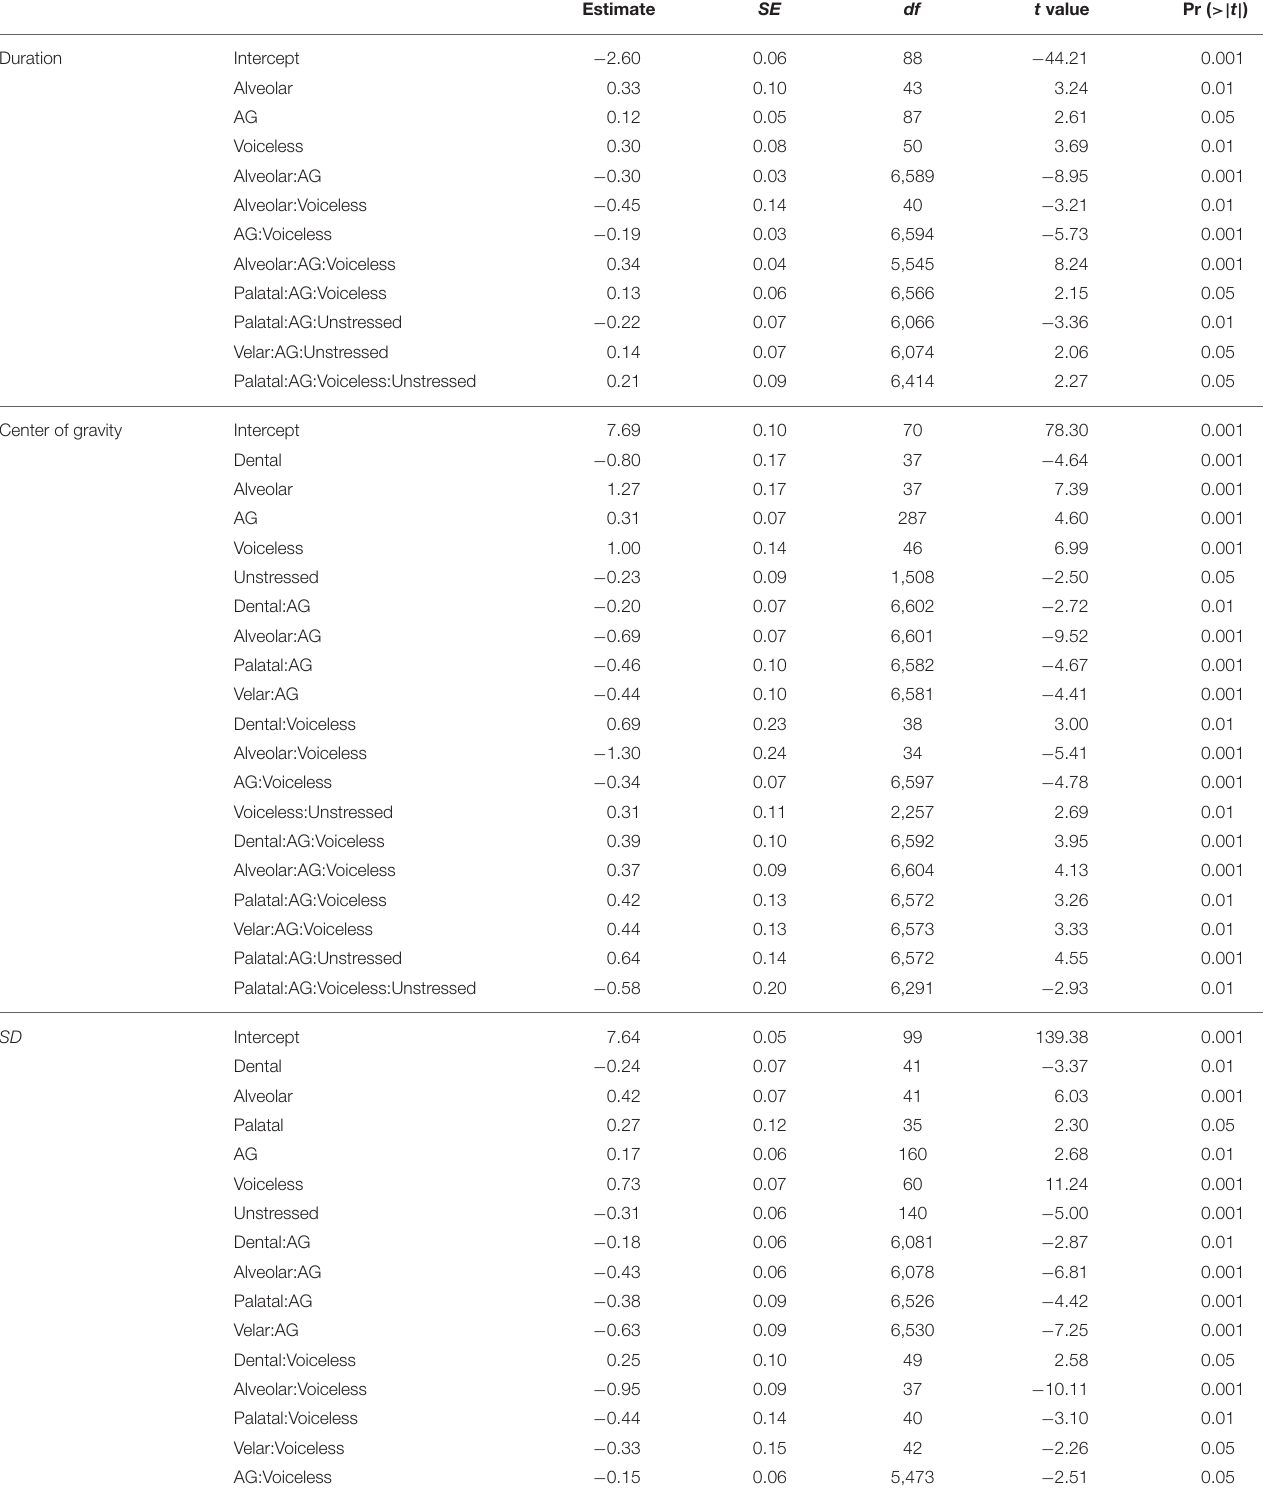
TABLE 4 | Results from the linear mixed effects models for the effects of the effects of dialect [Athenian Greek (AG) and Cypriot Greek (CG)], place of articulation, voicing, and stress on duration, center of gravity, and standard deviation. Estimate SE df t